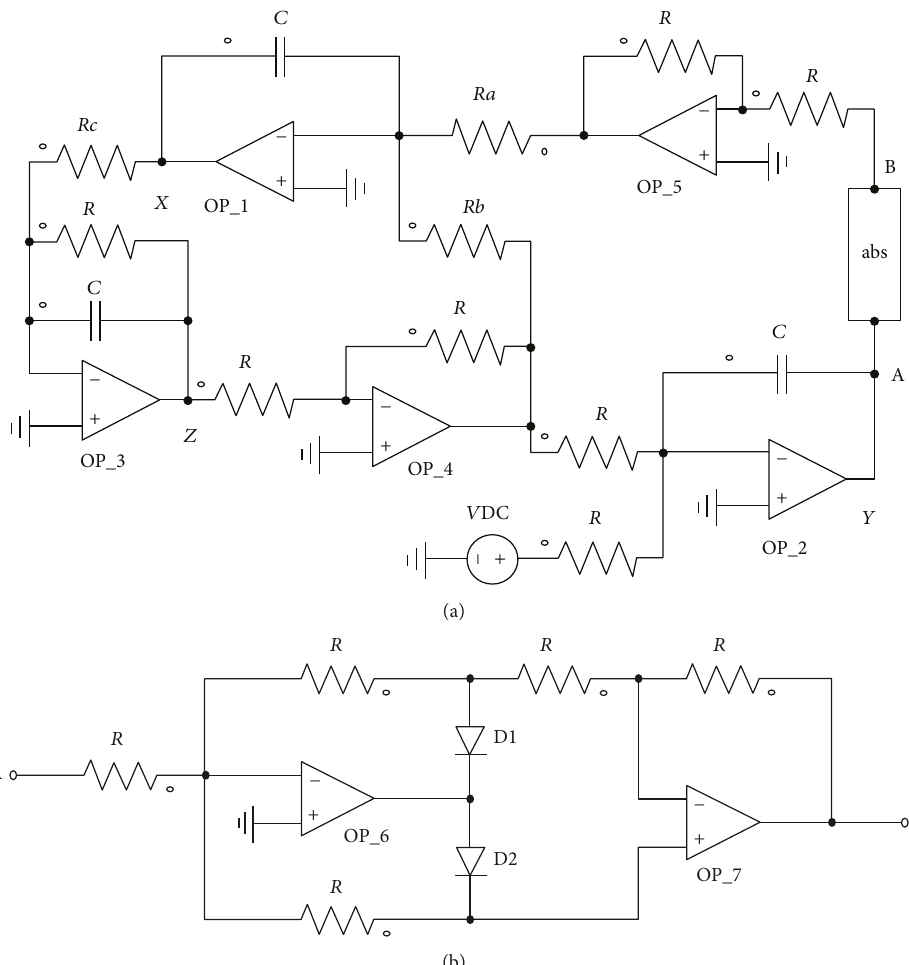
Figure 8: Electronic circuit design of system (1) (a) and the circuit realization of the absolute value function (b).